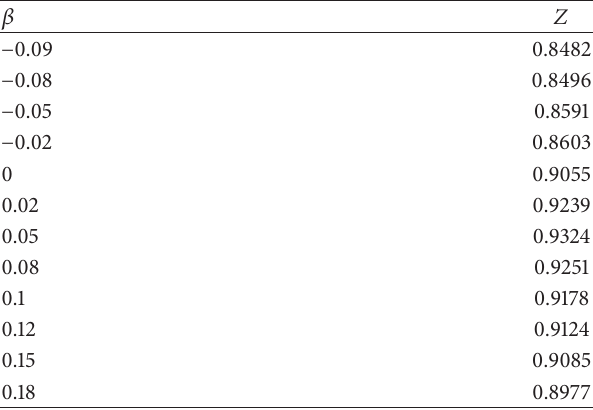
Table4:Theinfluenceof 𝛽